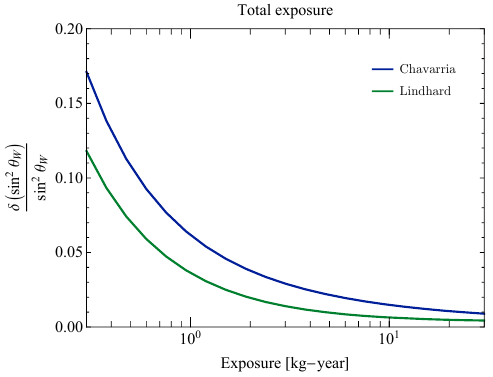
Figure 5 . Precision on the determination of sin 2 θ W as a function of the total exposure for Chavarria (blue) and Lindhard (green) quenching scenarios.